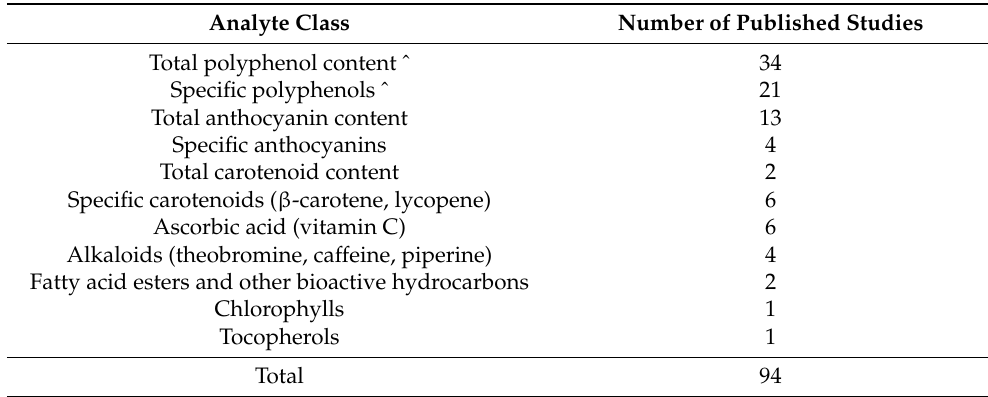
Table 5. Number of studies included in this review, broken down by analyte class. Note that if the same study investigated multiple matrices or investigated more than one analyte class in the same matrix, it was counted separately. Analyte Class Number of Published Studies Total polyphenol content ˆ 34 Specific polyphenols ˆ 21 Total anthocyanin content 13 Specific anthocyanins 4 Total carotenoid content 2 Specific carotenoids ( β -carotene, lycopene) 6 Ascorbic acid (vitamin